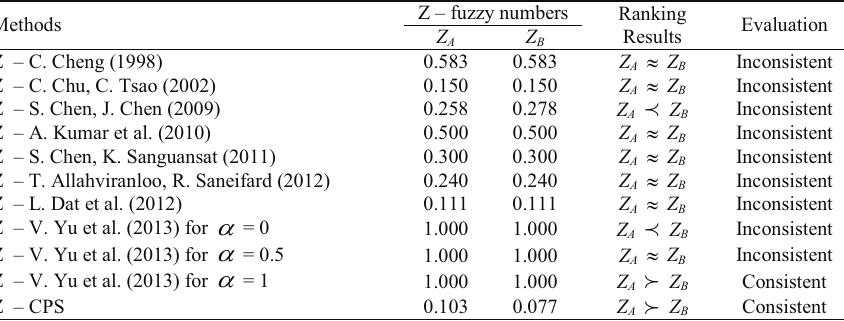
Table 2.Comparative results using Z – fuzzy numbers of Case 2.